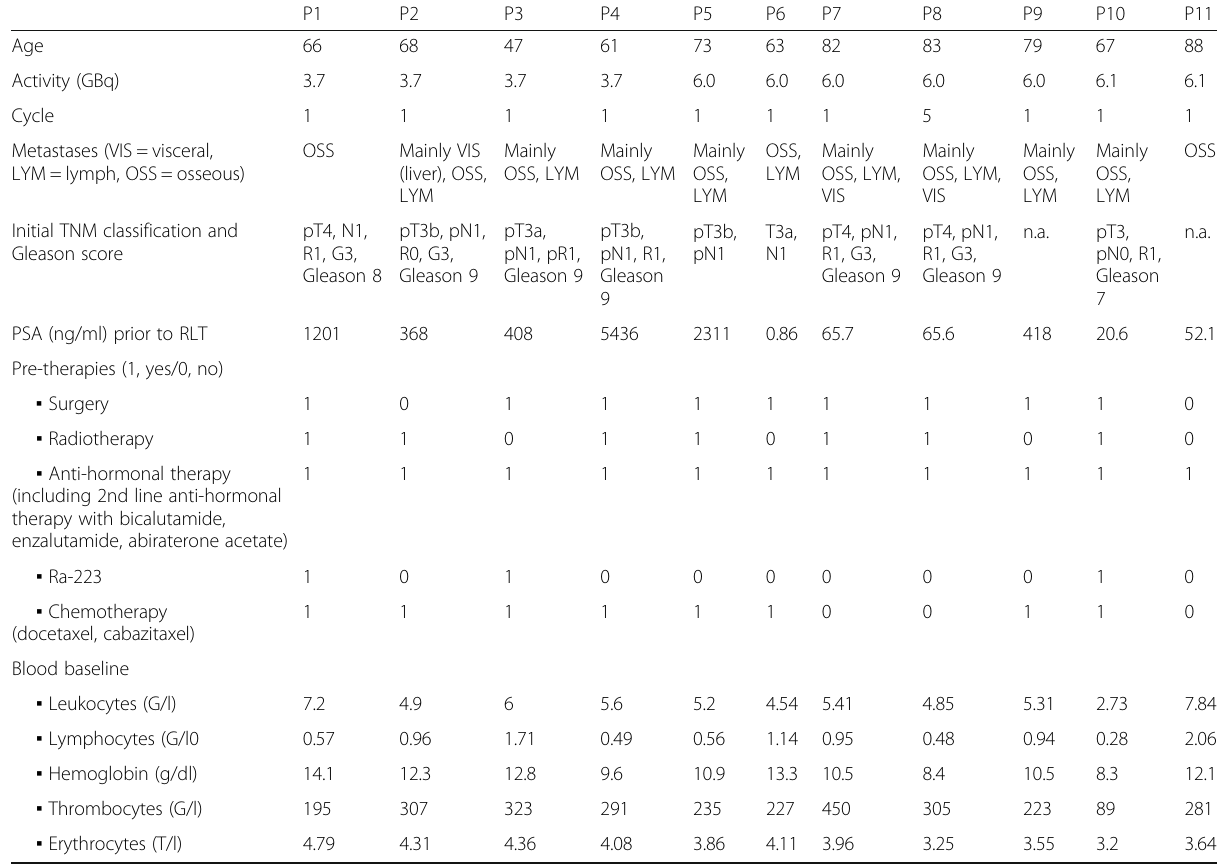
Table 1 Characteristics of mCRPC patients included in this study